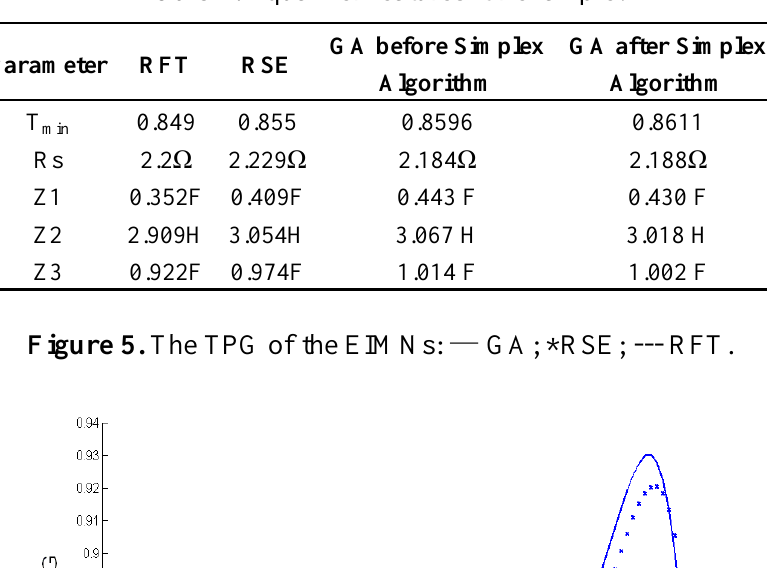
Table 1. Equalizer features for example.